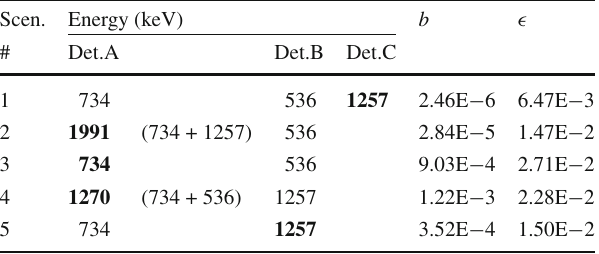
Table 2 The five most relevant scenarios that contribute to the total sensitivity to the neutrinoless decay channel by more than 1%. b is the background index (units: counts/keV/kg/y) and (cid:5) the total detection efficiency. The electrons are assumed to be always fully absorbed in the detector ’A’. The numbers within parentheses show how the energy is split between electrons (734 keV) and gammas in detector ’A’. The final fit is performed at the highest energy monochromatic peak measured in each signature, marked here in bold. The observed spectra for each scenario are shown in Fig. 3. Scenario numbers are unrelated to those